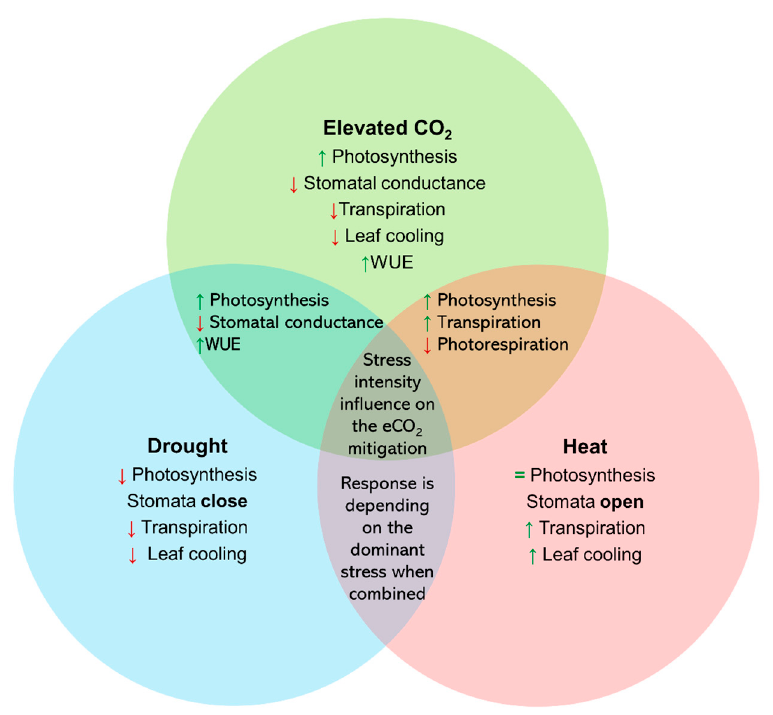
Figure 1. The effect of elevated CO 2 , drought, and heat stress individually and in combination on the main physiological responses of plants without the occurrence of other limiting factors.